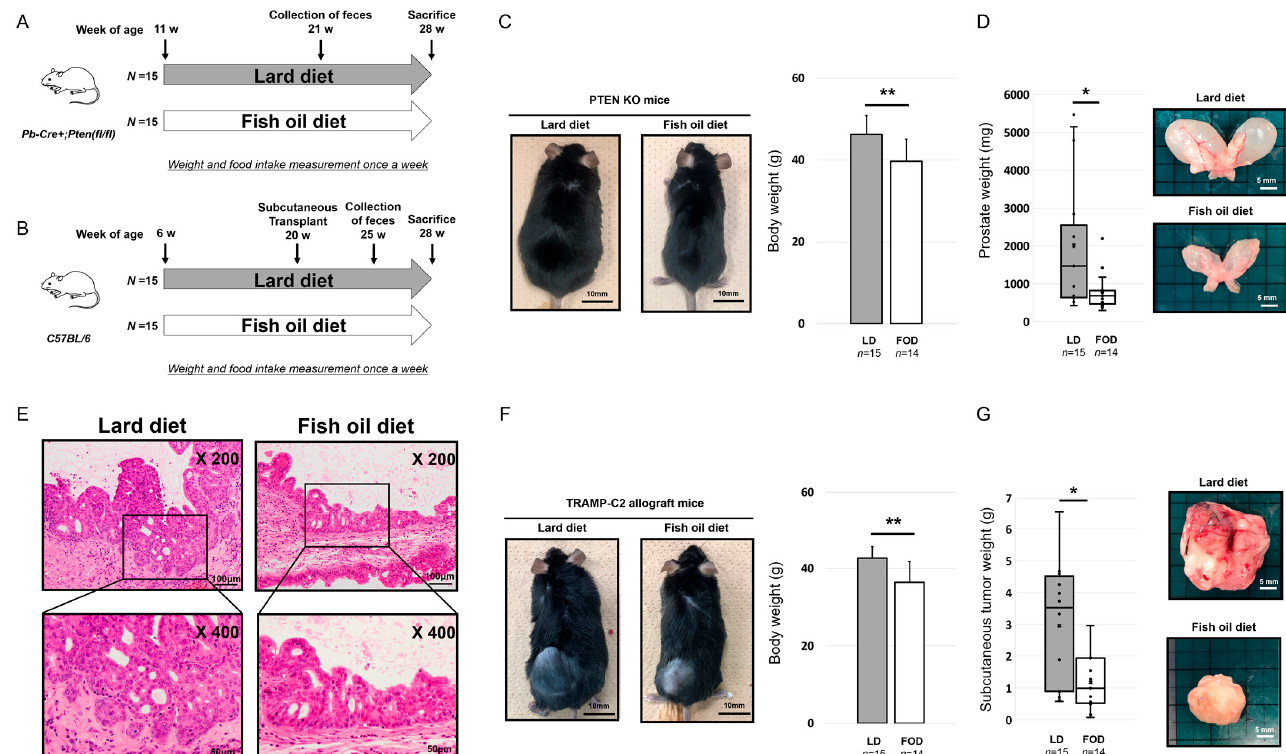
Figure 1. Saturated and monounsaturated fatty acids induce prostate cancer progression along with weight gain in two different immunocompetent mouse models. * p < 0.05, ** p < 0.01. ( A ) Experimental scheme of the Pten KO model. ( B ) Experimental scheme of the TRAMP-C2 allograft model. ( C ) Gross appearance and mean body weight of the Pten KO model fed with LD or FOD ( n = 15, 14, respectively). Black bars indicate 10 mm. ( D ) Mean prostate weight and gross appearance of the prostate in the Pten KO model fed with LD or FOD ( n = 15, 14, respectively). The line within a box indicates the median value. The round dots and cross marks indicate the value of each sample and the mean value, respectively. White bars indicate 5 mm. ( E ) Representative images of hematoxylin and eosin staining of the prostatic tissues in the Pten KO mice fed with LD or FOD. Magnification 200 × in the upper images and 400 × in the lower images. The scale bars indicate 100 µ m in the upper images and 50 µ m in the lower images. ( F ) Gross appearance and mean body weight of the TRAMP-C2 allograft model fed with LD or FOD ( n = 15, 14, respectively). Black bars indicate 10 mm. ( G ) Mean tumor volume and gross appearances of subcutaneous tumor in the TRAMP-C2 allograft model fed with LD or FOD ( n = 15, 14, respectively). The line within a box indicates the median value. The round dots and cross marks indicate the value of each sample and the mean value, respectively. White bars indicate 5 mm. LD, lard diet; FOD, fish oil